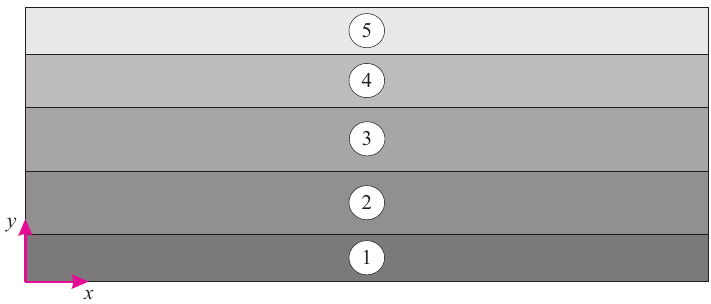
Figure 6. Scheme of the equivalent plates of the homogenized